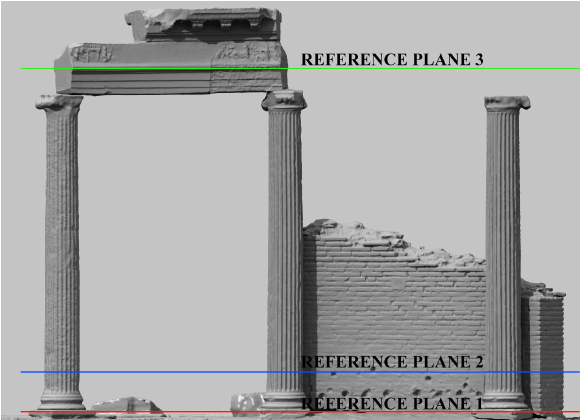
Figure 4. Reference planes at different levels for best fitting circumference’s extraction